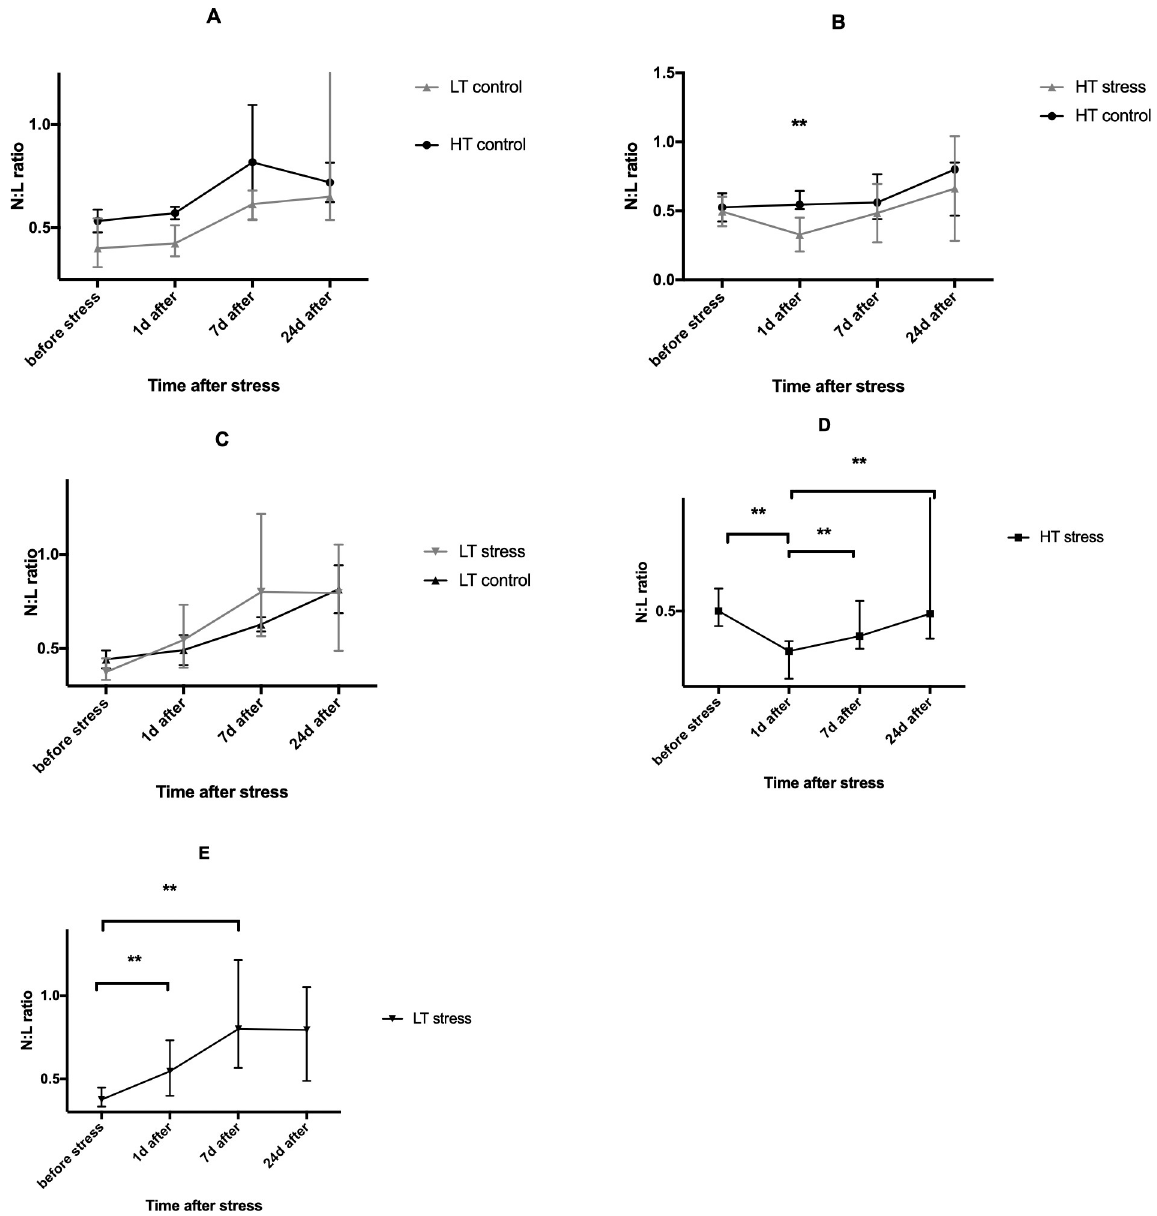
Fig 5. Effect of long-term stress on neutrophil:lymphocyte ratio (N:L ratio) in LT and HT rats. Intertrain comparison of intact rats (A), effect of stress on N:L ratio in HT strain (B), effect of stress on N:L ratio in LT strain (C), dynamics of stress related changes in N:L ratio in HT (D) and in LT rats (E). LT control–low excitability threshold, control group, LT stress–low excitability threshold, stressed animals; HT control– high excitability threshold, control group, HT stress–high excitability threshold, stressed animals; n = 9–11 per group; bars represent medians and interquartile range; B— �� p � .01 (Mann-Whitney test), D-F �� —p � .01 (Wilcoxon test with FDR correction).